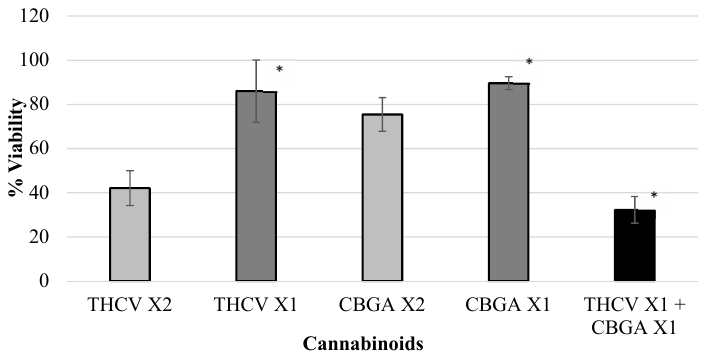
Figure 5. Viability of polyp cells exposed to THCV and CBGA. Combinations between THCV (at X2 concentration—40/48 µM or X1 concentration—20/24 µM) and CBGA (at X2 concentration—51.2 µM or X1 concentration—25.6 µM) significantly inhibited the viability of polyp-derived cells. The cannabinoid combination THCV + CBGA (* p < 0.0025, Bliss equation calculation = 0.45) presented a synergistic effect. Legend: tetrahydrocannabivarin (THCV), cannabigerolic acid (CBGA).